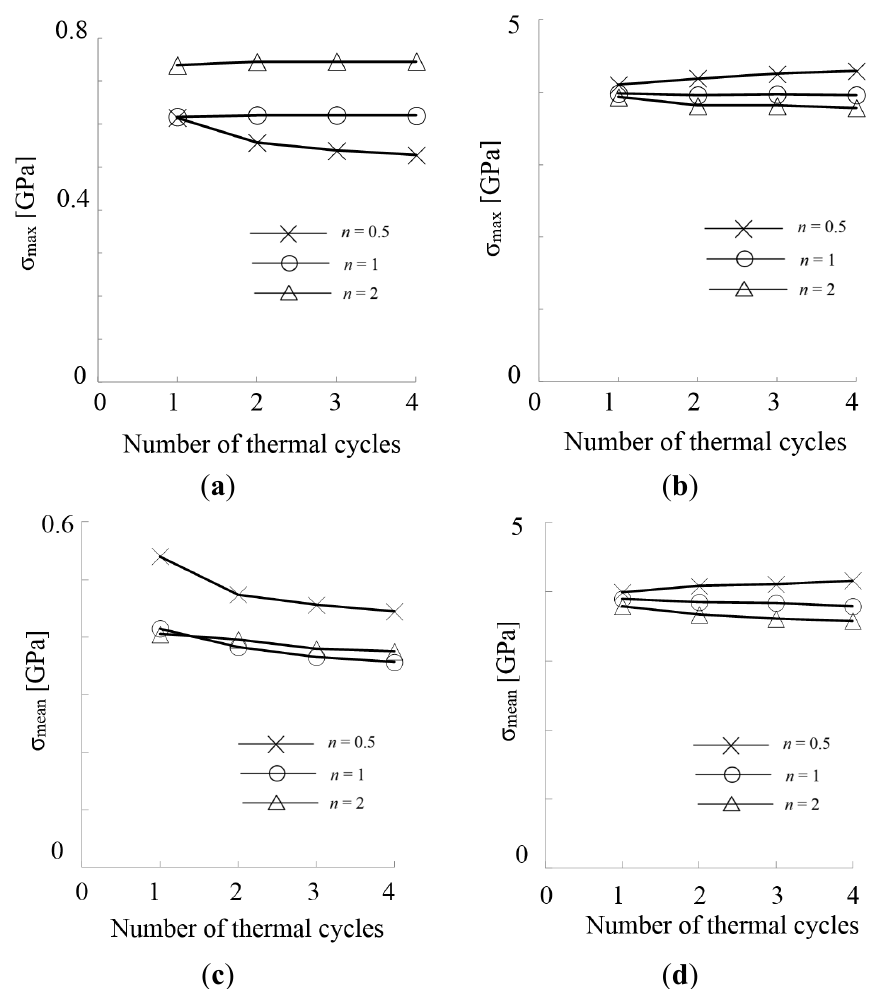
Figure 6. Maximum thermal stresses, σ max , and mean thermal stresses, σ mean , in ZrO 2 surface layer during thermal shock cycling. ( a ) σ max for d ZrO ( c ) σ mean for d ZrO = 0.01 μ m, and ( d ) σ mean for d ZrO 2